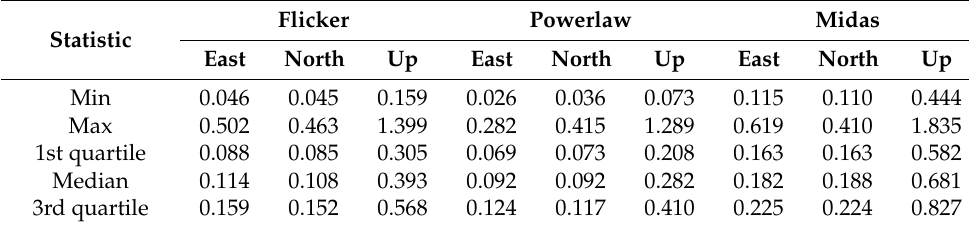
Table 4. Statistics of uncertainties of the velocity in